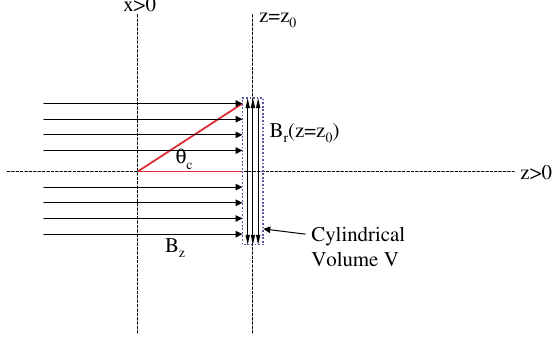
FIG. 2. (Color) A beam passing through an idealized solenoid which consisting of a uniform longitudinal magnetic field B z and a radial field of infinitess- drops abruptly to zero at z (cid:4) z 0 . The cylindrical Gaussian volume V , as imal length at z (cid:4) z 0 defined in the text, is